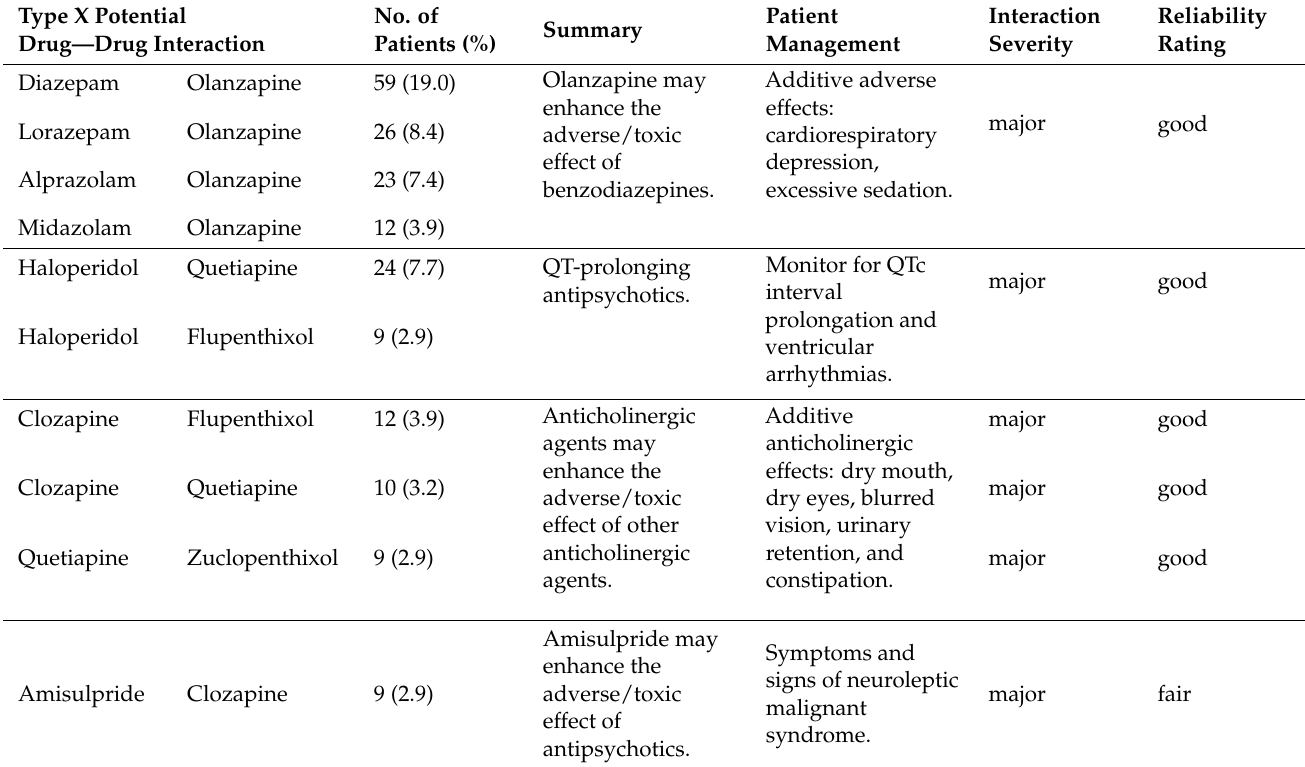
Table 2. Ten most common type X pDDIs in all patients (n = 311), the summary of interaction, patient management, severity, and reliability rating.